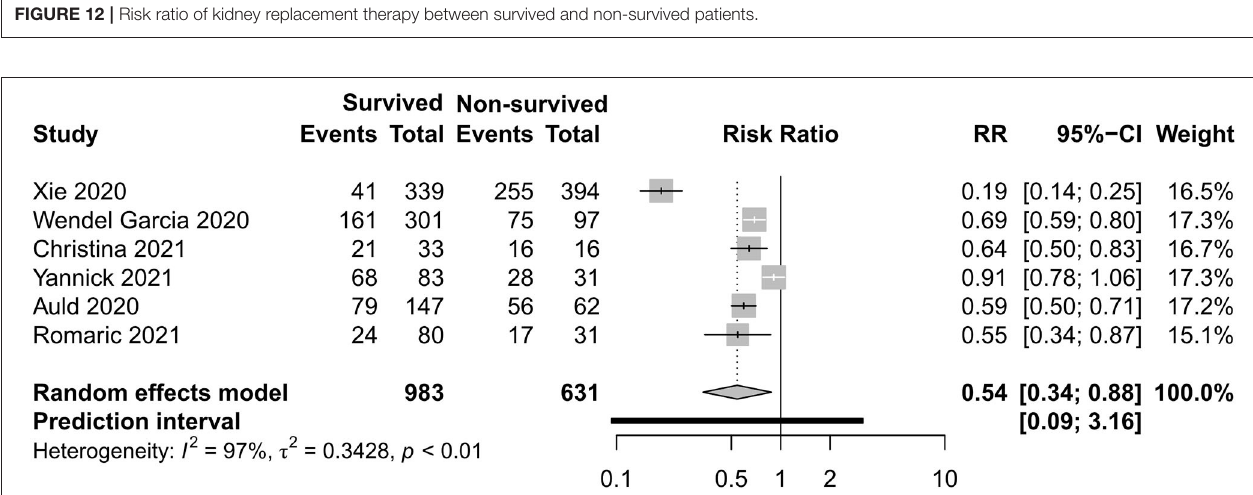
FIGURE 12 | Risk ratio of kidney replacement therapy between survived and non-survived patients.